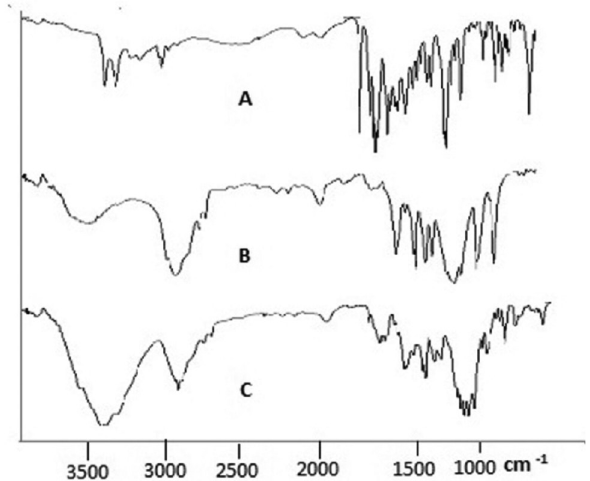
FIGURE 4 - FTIR spectra of (A) Pure drug (B) PEO 301 powder (C) CCT with PEO WSR